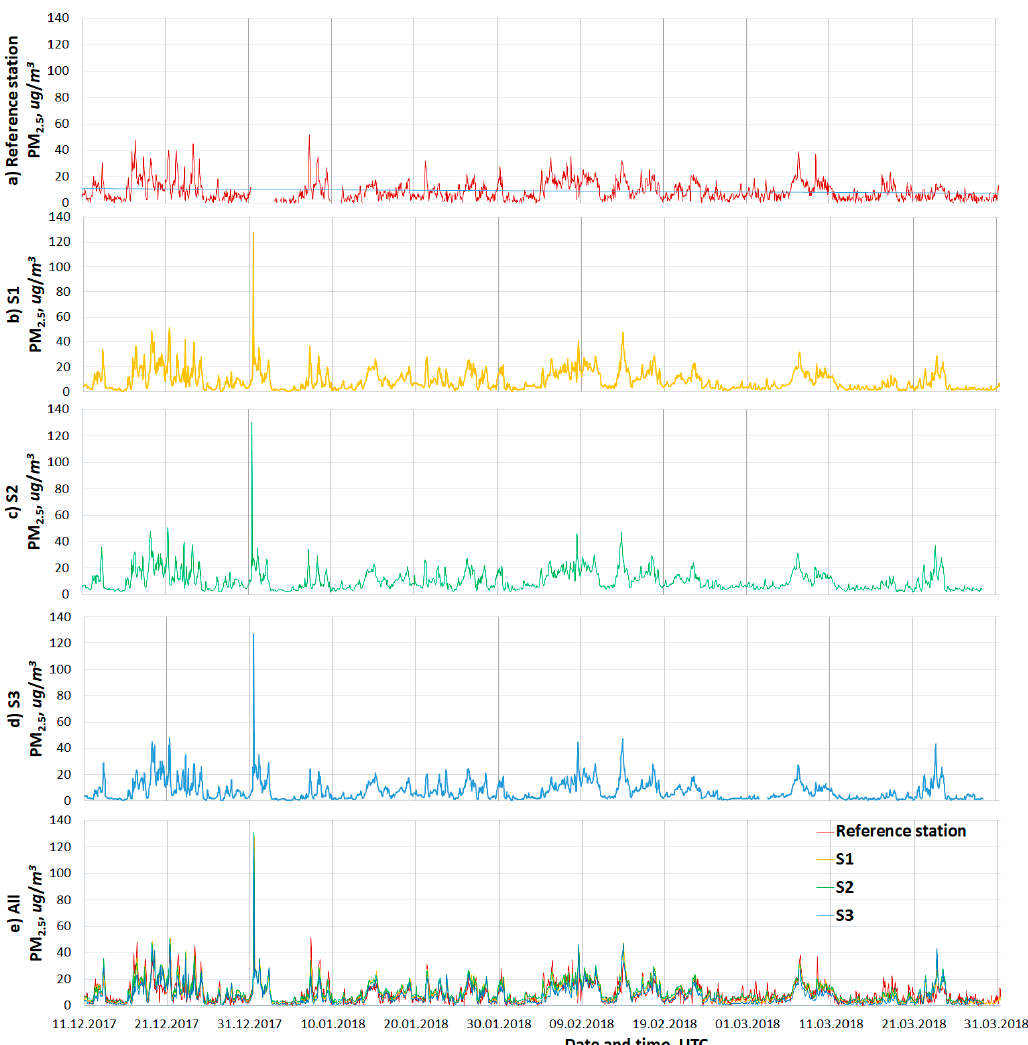
Figure 4. Results of PM 2.5 measurement from three SDS011 sensors and an official reference monitoring station in the period of 11 December 2017 to 31 March 2018: ( a ) Official reference station; ( b ) S1; ( c ) S2; ( d ) S3; ( e ) Comparison among the official reference station and three SDS011 sensors. 1 h averaged data was plotted.